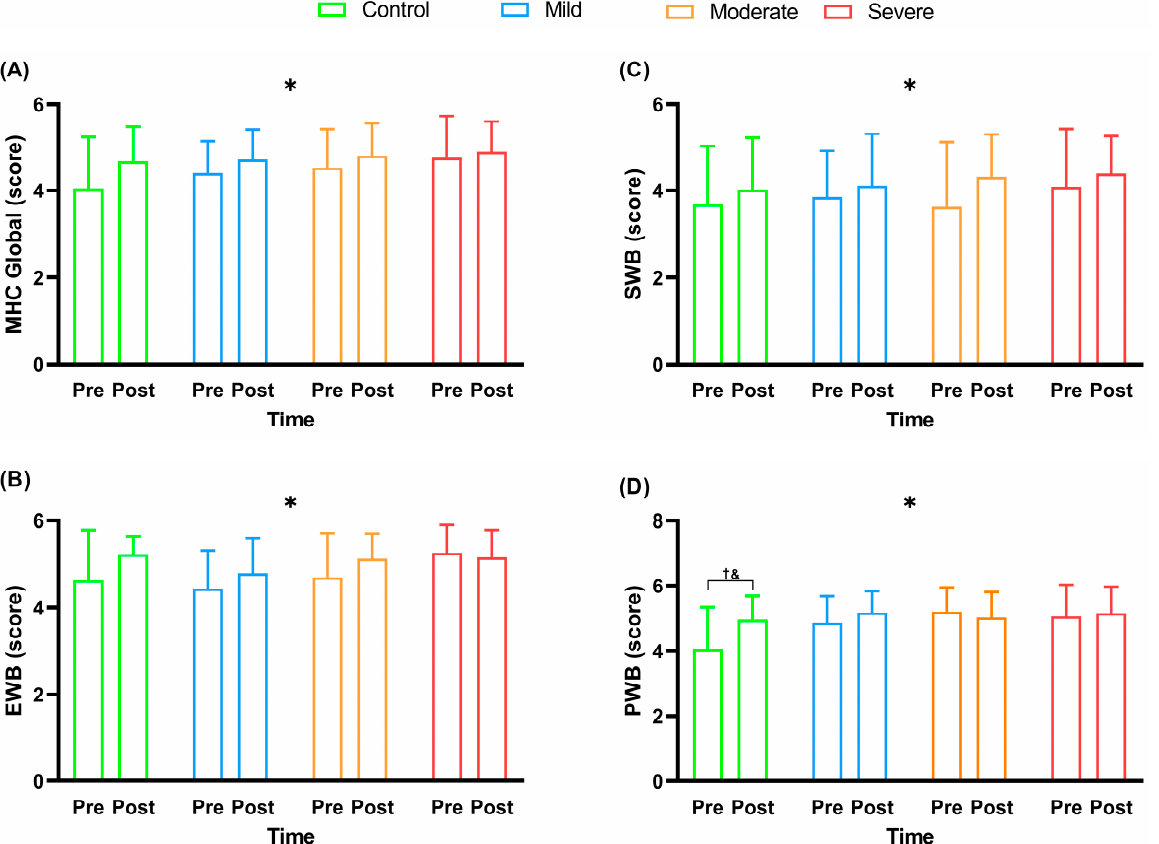
Figure 3. Mental Health Continuum (MHC) scores before and after multi-professional interventions. Data were described as mean and standard deviation ( ± ); MHC = Mental Health Continuum; EWB = emotional well-being; SWB = social well-being; PWB = psychological well-being; * = timing effect (pre- vs. post-intervention); † = interaction between pre- and post-intervention for the control group ( p < 0.05); & = interaction with significantly higher values for the control group when compared to the moderate group ( p < 0.05); Panel ( A ) = MHC score Global; Panel ( B ) = EWB score; Panel ( C ) = SWB score; Panel ( D ) = PWB